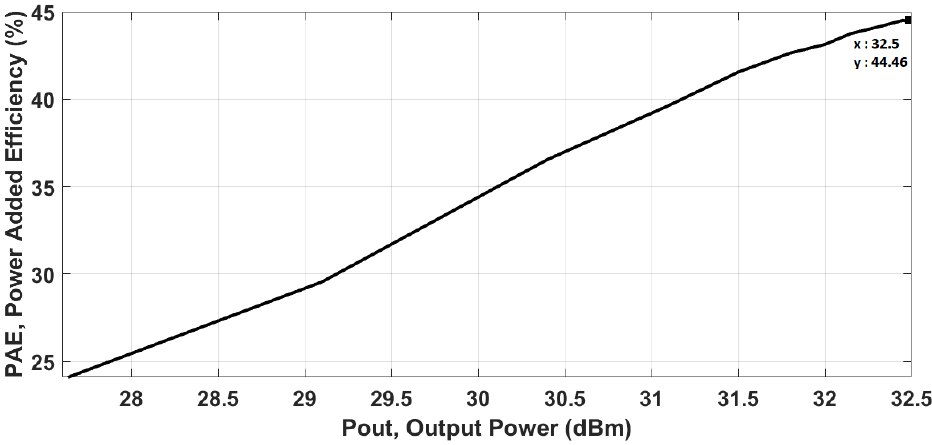
Figure 13. Performance of the signal condition chain with different modulations.